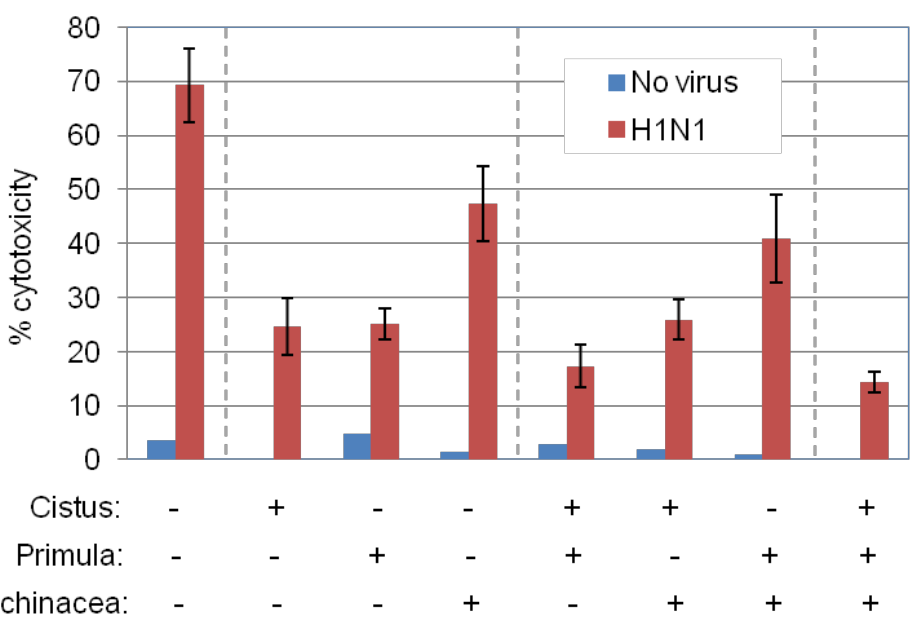
Figure 4. Prophylactic effects of P. veris on influenza virus cytolysis. MDCK cells were incubated for 4 h with 50 µ g/mL Primula extracts isolated by supercritical CO 2 + 13% EtOH, and then infected with H1N1 at MOI = 0.2 according to the protocol of Figure 1B. Echinacea (EtOH/H 2 O-Xad7-derived) and Cistus (hydroethanolic) extracts were used in parallel for comparison, in the presence or absence of Primula extract. The graph depicts virus-induced MDCK cell lysis, assessed by LDH release assays. Data are the average of duplicate determinations from 3 independent experiments.